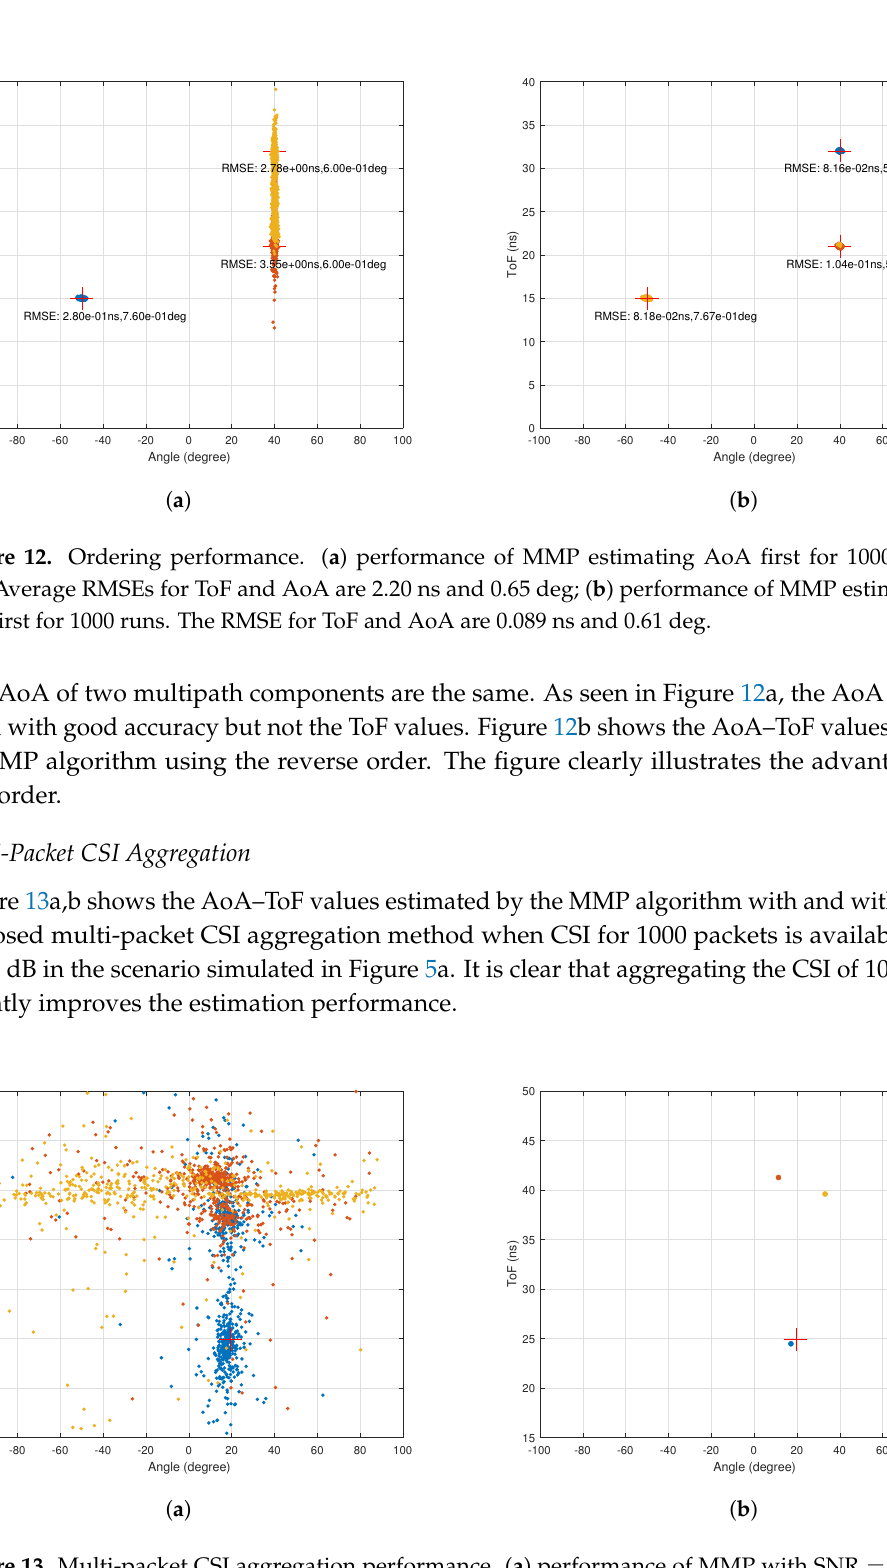
Figure 13. Multi-packet CSI aggregation performance. ( a ) performance of MMP with SNR = 20 dB for 1000 runs. The RMSEs for AoA and ToF are 12.39 deg and 22.92 ns. Simulation time is 0.76 s; ( b ) performance of MMP using the multi-packet CSI aggregation method when SNR = 20 dB for one run using CSI of 1000 packets. The RMSEs for AoA and ToF are 2.29 deg and 0.46 ns. Simulation time (including CSI aggregation) is 0.14